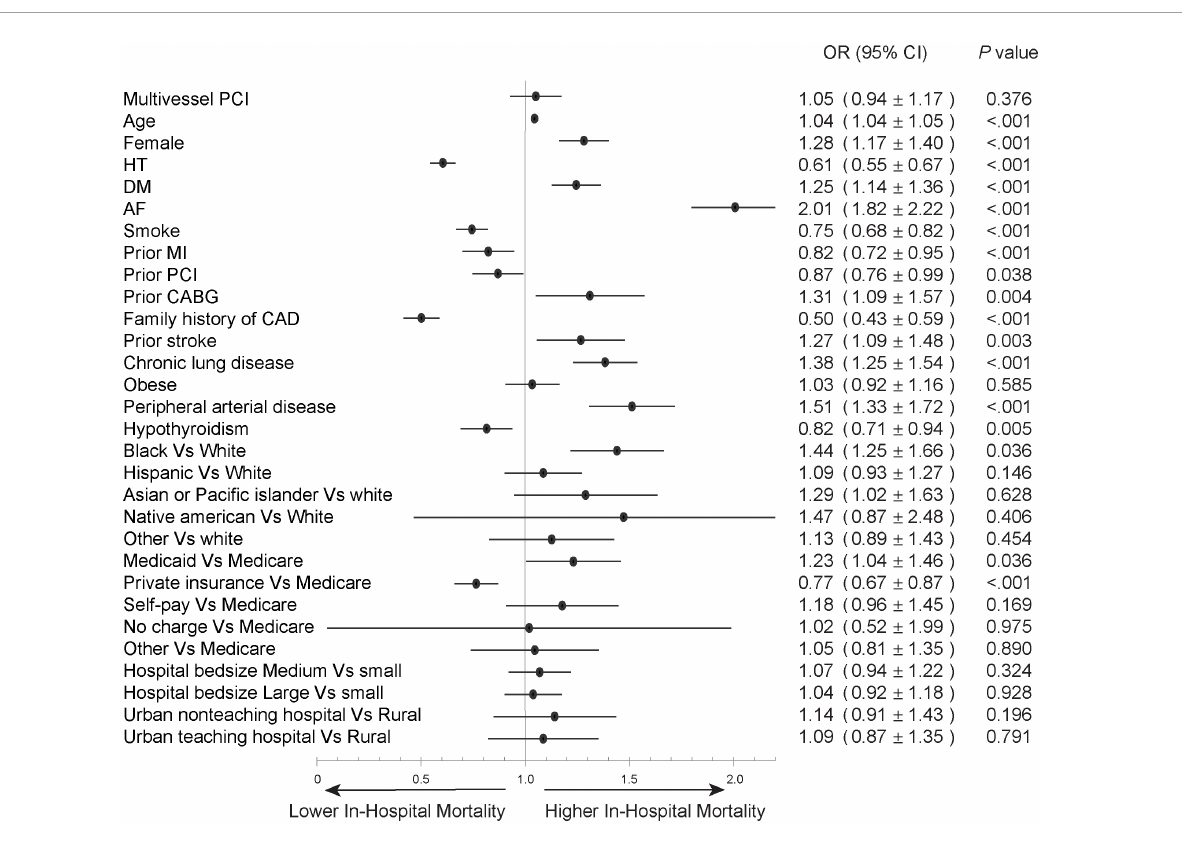
FIGURE4 Forest plot of multivariable regression analysis to predict in-hospital mortality in the STEMI without cardiogenic shock cohort. Abbreviations as in Figure 3